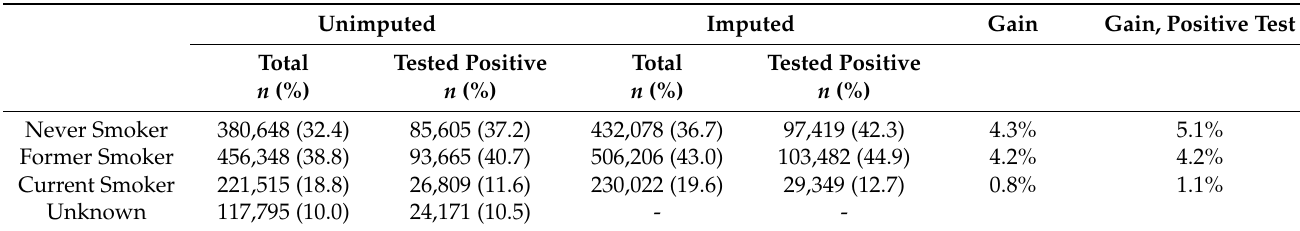
Table 2. Patient smoking status before and after imputation.